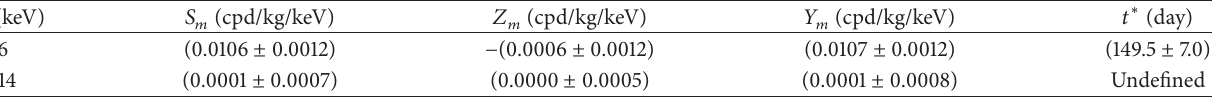
Table 1: Best fit values for the (2–6) and (6–14) keV energy intervals ( 1𝜎 errors) for 𝑆 𝑚 versus 𝑍 𝑚 and 𝑌 𝑚 versus 𝑡 ∗ , considering the cumulative exposure of DAMA/NaI and DAMA/LIBRA-phase1. See also Figure 6.